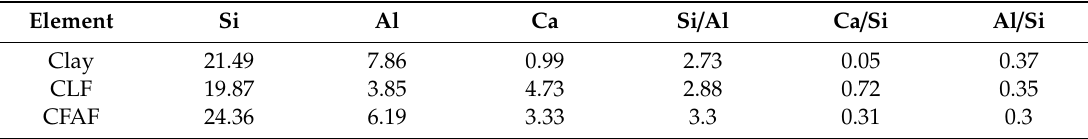
Table 7. Energy Dispersive X-Ray Element for All Specimens.